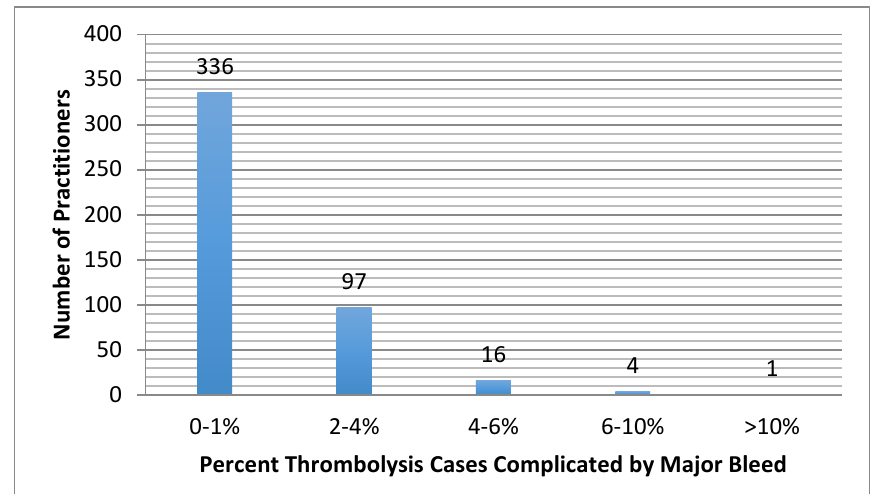
Figure 6. Self-reported percentage of thrombolysis cases that are complicated by major bleeding, including intracranial hemorrhage, gastrointestinal bleed requiring transfusion or intervention, or retroperitoneal bleed requiring transfusion or intervention.